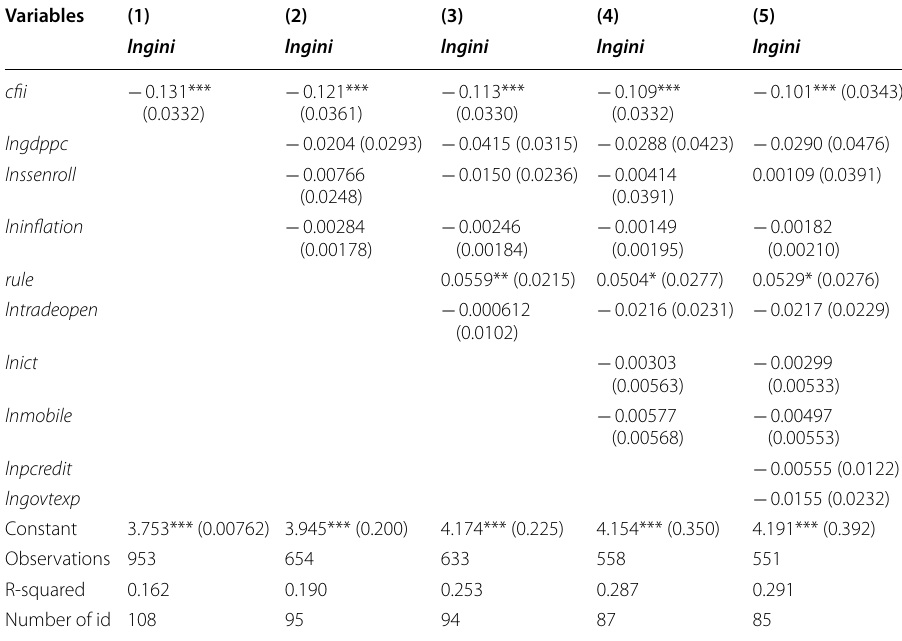
The dependent variable is income inequality measured by Gini coefficient. For details of the explanatory variables, see Appendix B. All standard errors are robust and reported in parentheses. The symbols ***, **, and * indicate statistical significance at the 1%, 5%, and 10% level,